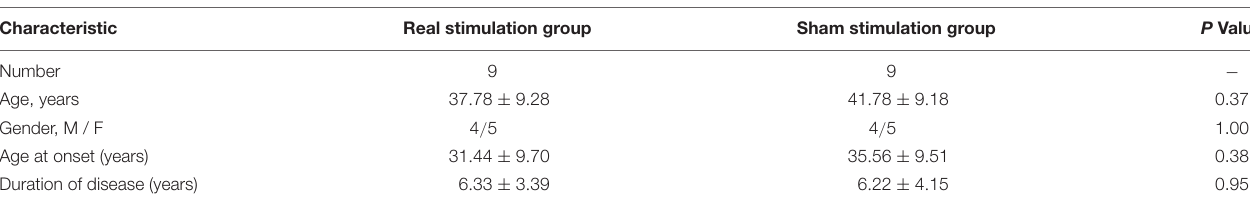
FIGURE 1 | Schematic diagram of the research process. Nine individuals were randomly assigned to the low-frequency rTMS intervention, nine were assigned to the sham intervention, and zero dropped out of the experiment, but two participants in the real stimulation group were not included in the imaging data because they were unable to cooperate with the second MRS examination. TABLE 1 | The analysis of baseline data from the patients with SCA3.